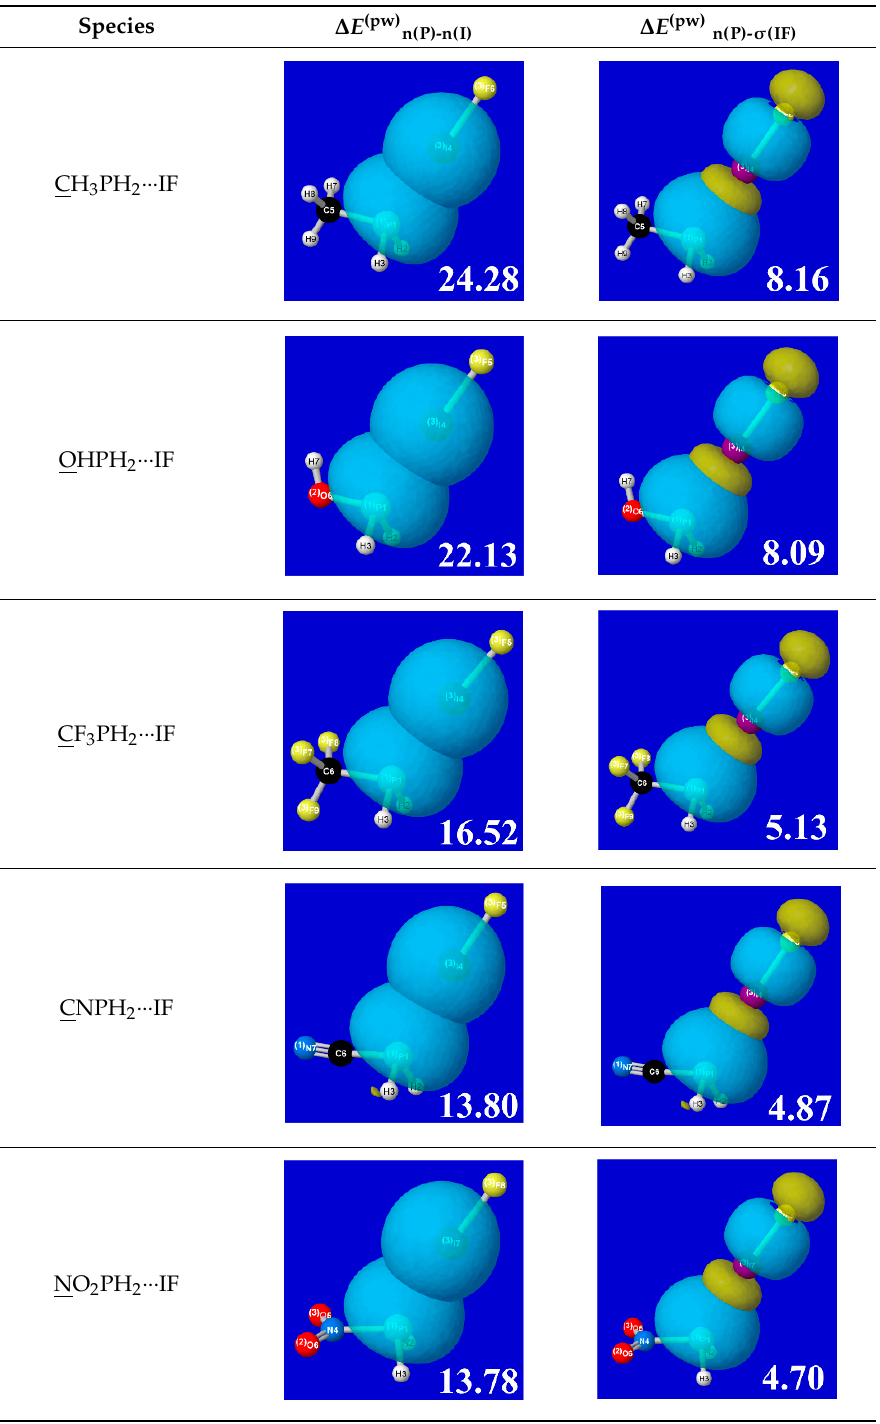
Table 5. Δ E (pw)donor–donor repulsion energy estimates (kcal/mol) for leading n P - n I and n P - σ IF steric clashes of RPH 2 ···IF complexes, obtained from steric-keyword analysis.